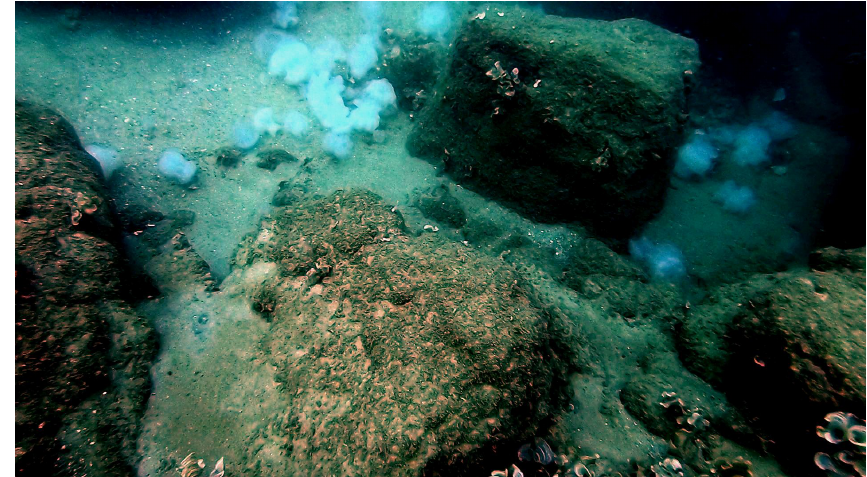
Figure 1. Jelly-falls (carcasses) of approximately 30 Rhopilema nomadica on the Mediterranean coast of Caesarea, Israel. The image shows a depth of 8–9m and was photographed on 27 July 2019 after the typical peak summer bloom (Photo: Zvika Fayer).